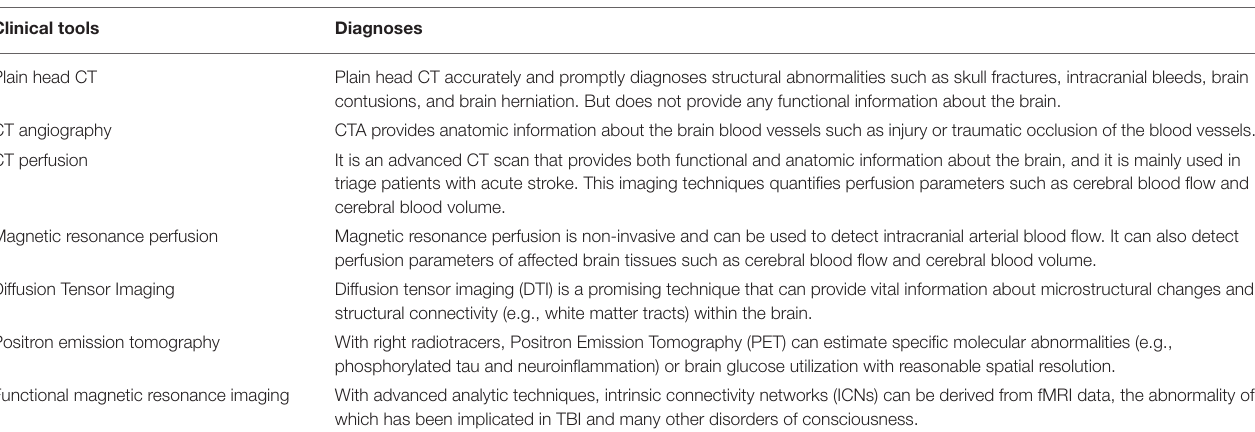
TABLE 1 | Categories of advanced neuroimaging in moderate/severe